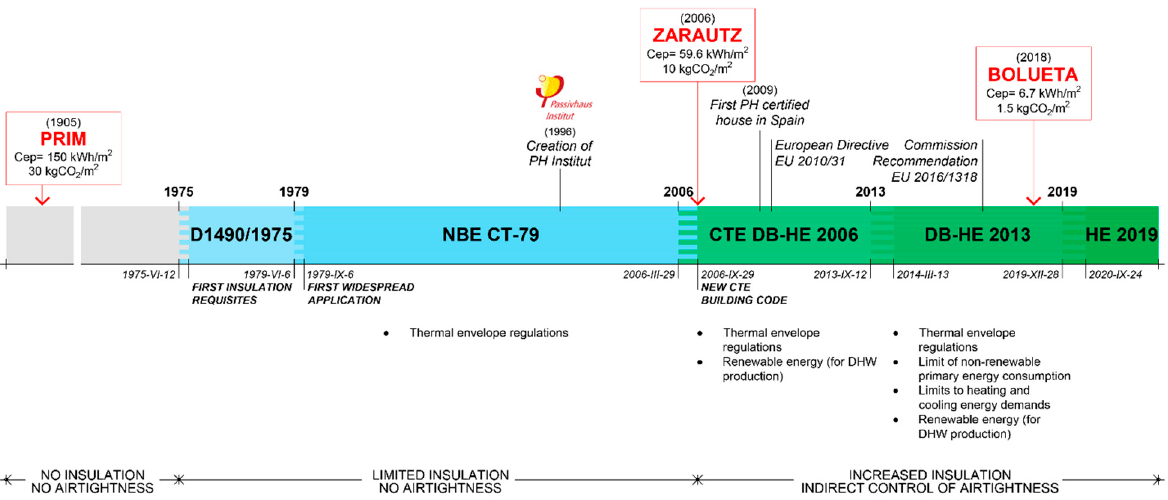
Figure 1. Evolution of the national energy efficiency regulations in Spain. The striped areas show the period of optional/voluntary application of the standards. The figure also shows some mile- stones of the implementation of the Passivhaus standard in Spain and places in time the case studies that are described in Section 2, summarizing their nominal primary energy consumption and CO 2 emissions. Source: authors.